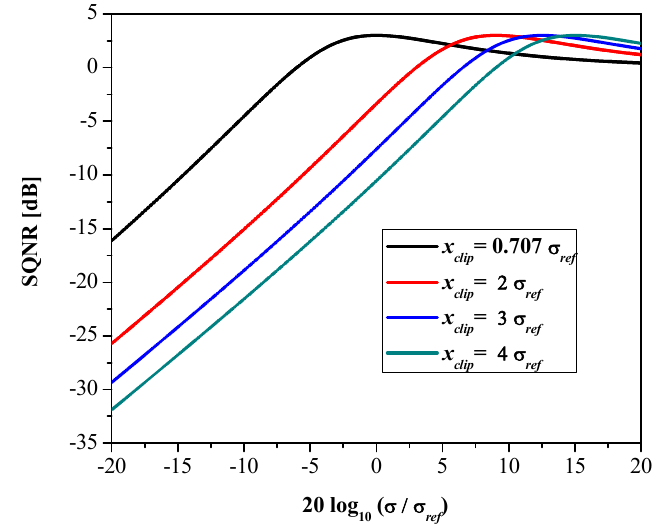
Figure 7. SQNR as a function of input signal variance for binary quantizer type 2.